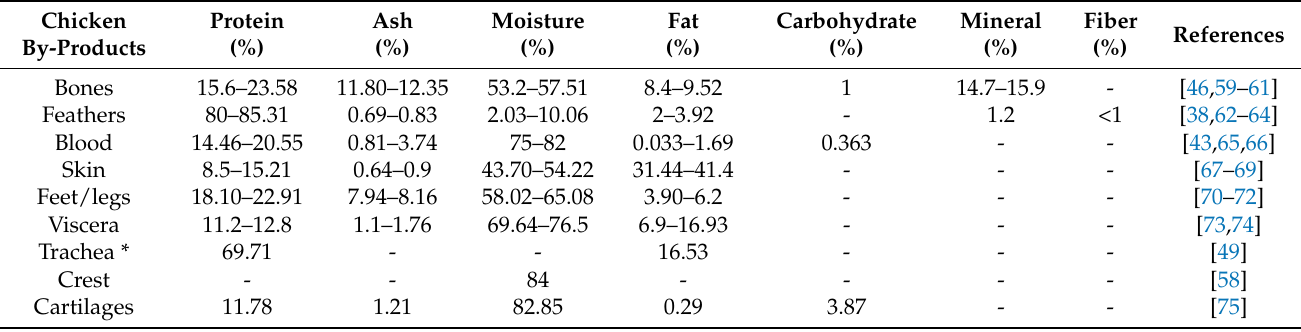
Table 1. Composition of chicken byproducts (% wet